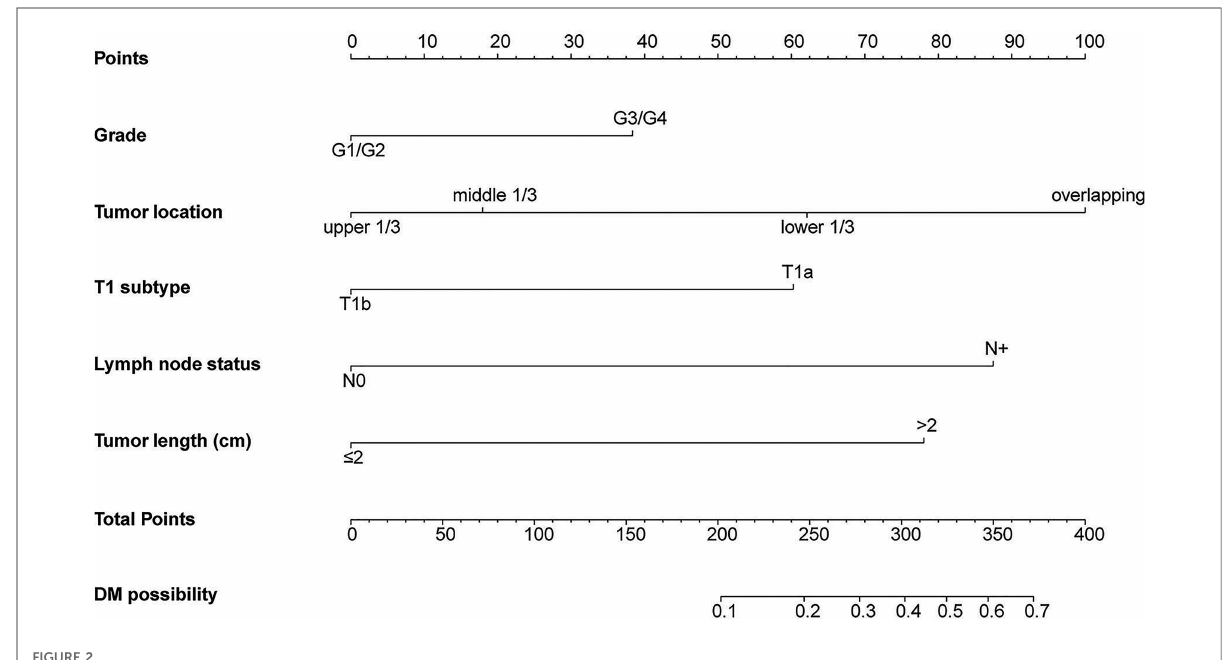
FIGURE 2 Nomogram for predicting DM in T1 EC patients.